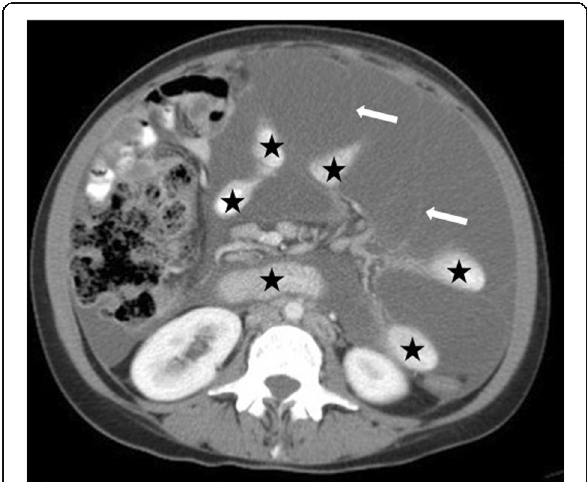
Fig. 31 A 39-year-old female patient with progressive abdominal distension underwent an US exam which showed large volume ascites in the abdomen. The clinical and imaging findings were concerning for peritoneal carcinomatosis. Axial plane CT image after IV and oral contrast use reveals a large cystic lesion insinuating between the mesenteric leaves. This cystic mass was separating apart the adjacent bowel loops (stars). Also noted were internal septations (arrows) within this large cystic mass. Surgical and subsequent histopathological examinations confirmed large mesenteric